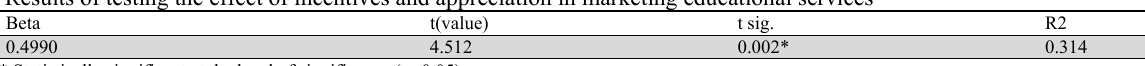
Results of testing the effect of incentives and appreciation in marketing educational